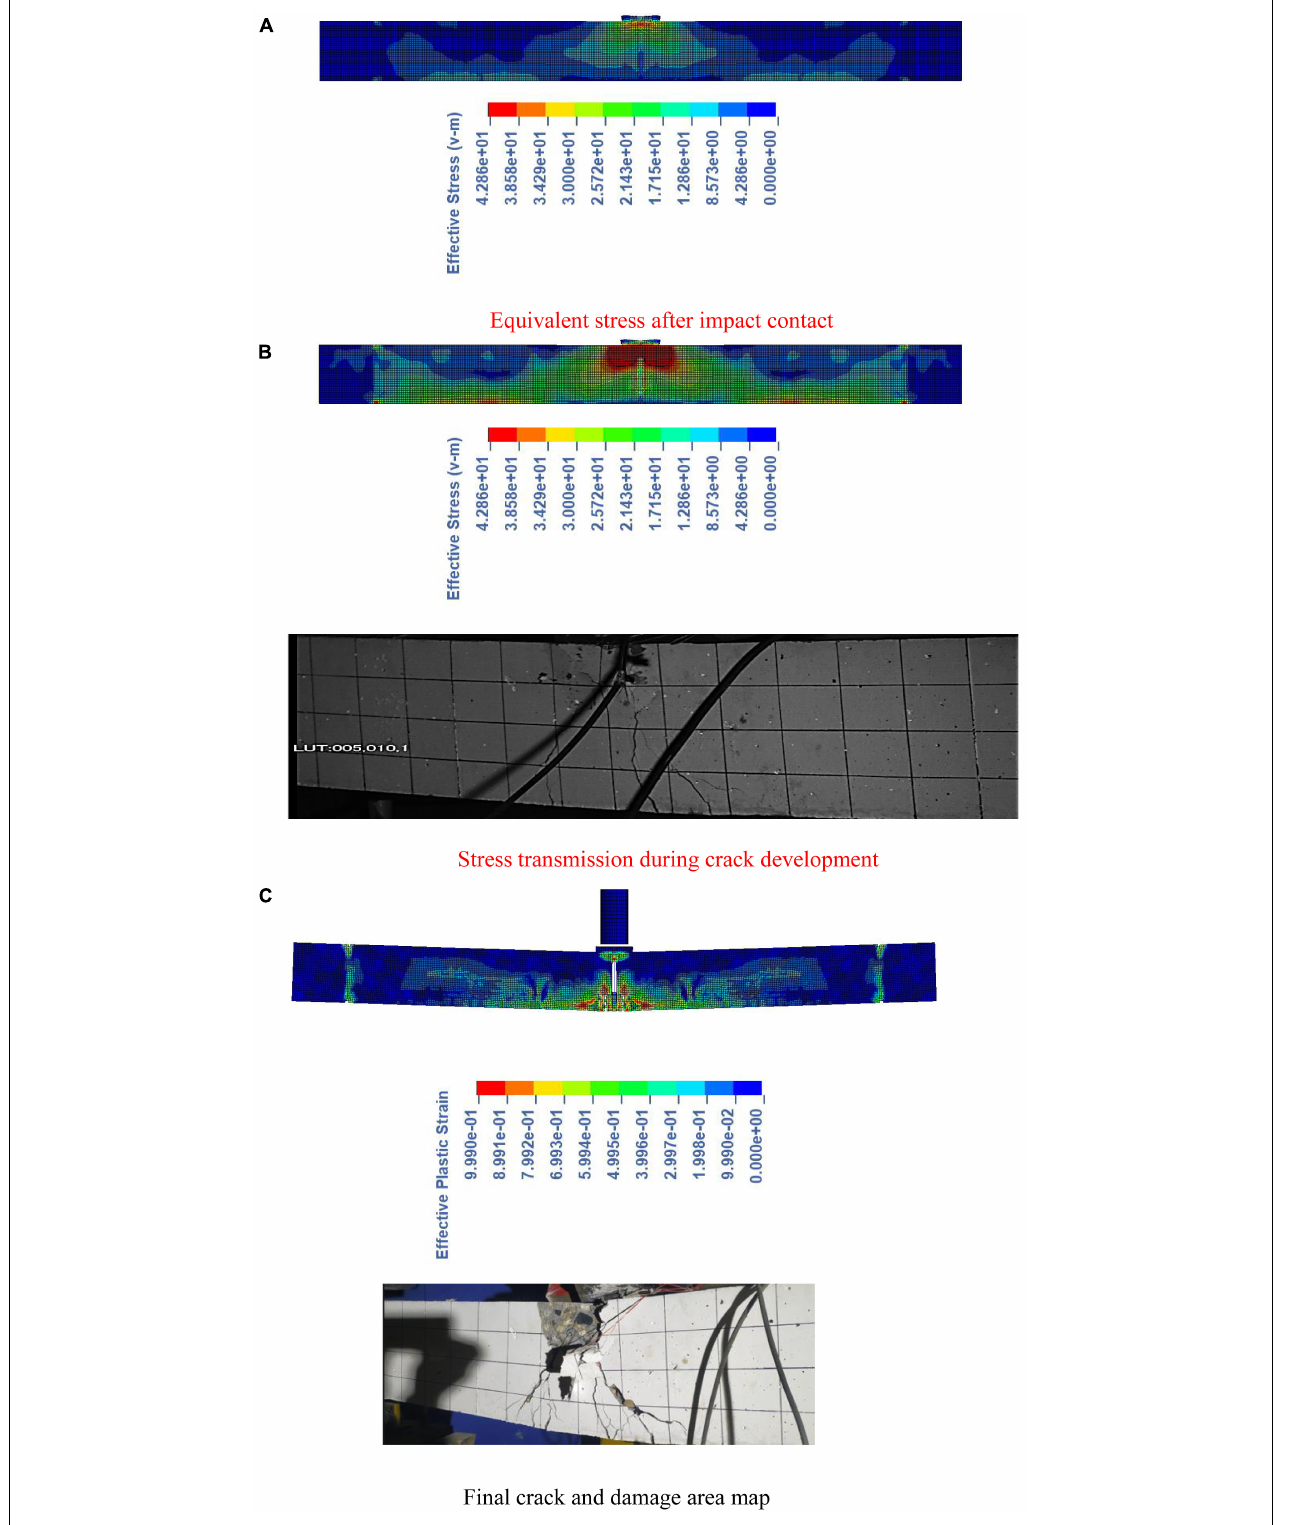
FIGURE 5 | Comparison of cracks and damage patterns. (A) Equivalent stress after impact contact. (B) Stress transmission during crack development. (C) Final crack and damage area map.